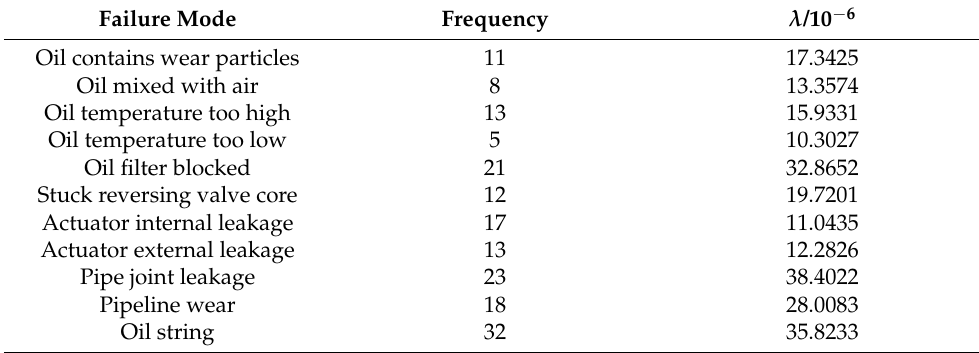
Table 2. Statistics of landing gear failure modes.